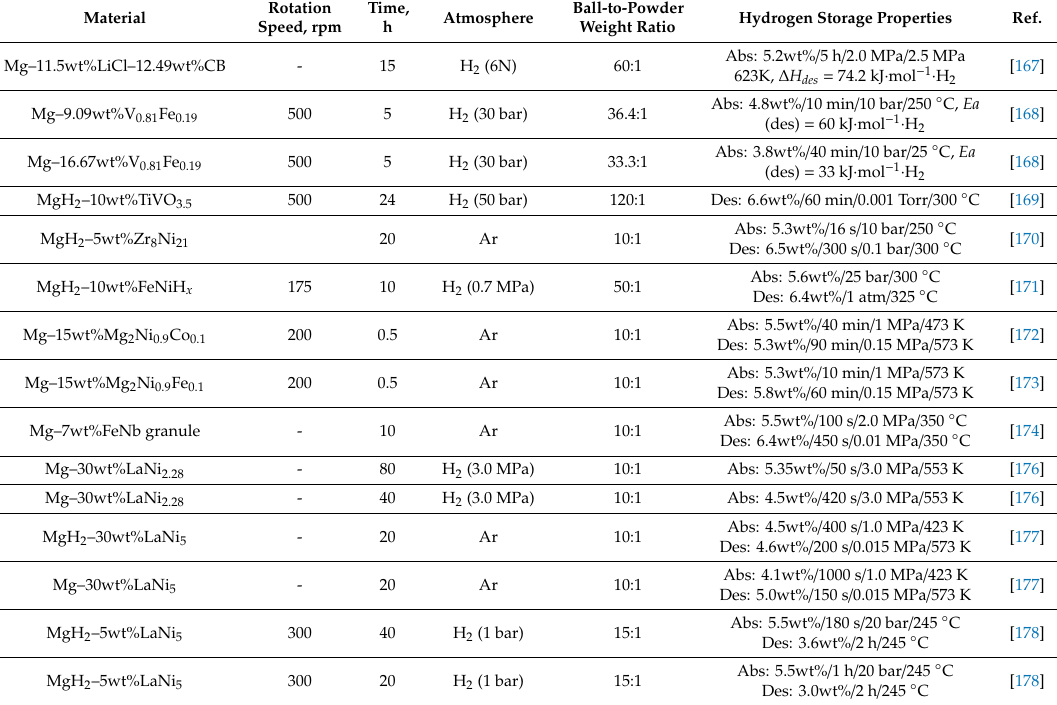
Table 6. Hydrogen storage properties of selected Mg modified by intermetallic compounds.